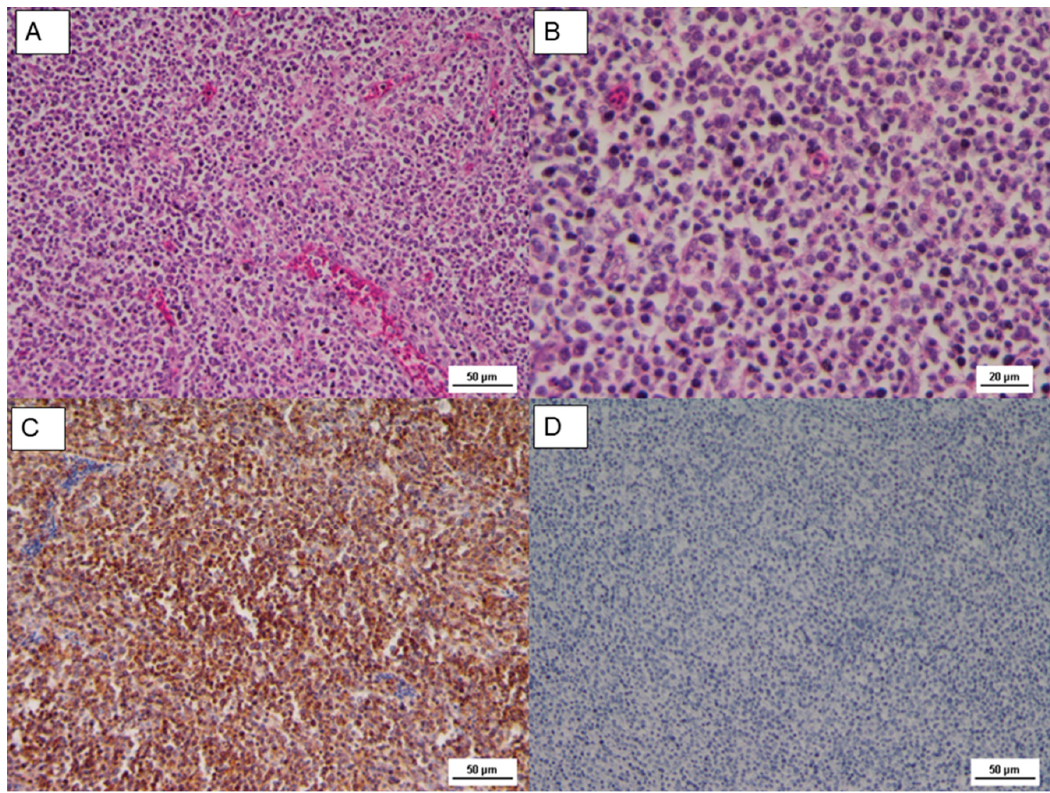
Figure 2. ( A ) Microscopic lesion of tumor mass, uniform proliferation of lymphoblast and small to medium lymphocyte, HE, Scale bar = 50 μ m; ( B ) HE, Scale bar = 20 μ m; ( C ) IHC CD3, diffuse positive staining, Scale bar = 50 μ m; ( D ) IHC CD20, negative staining, Scale bar = 50 μ m.